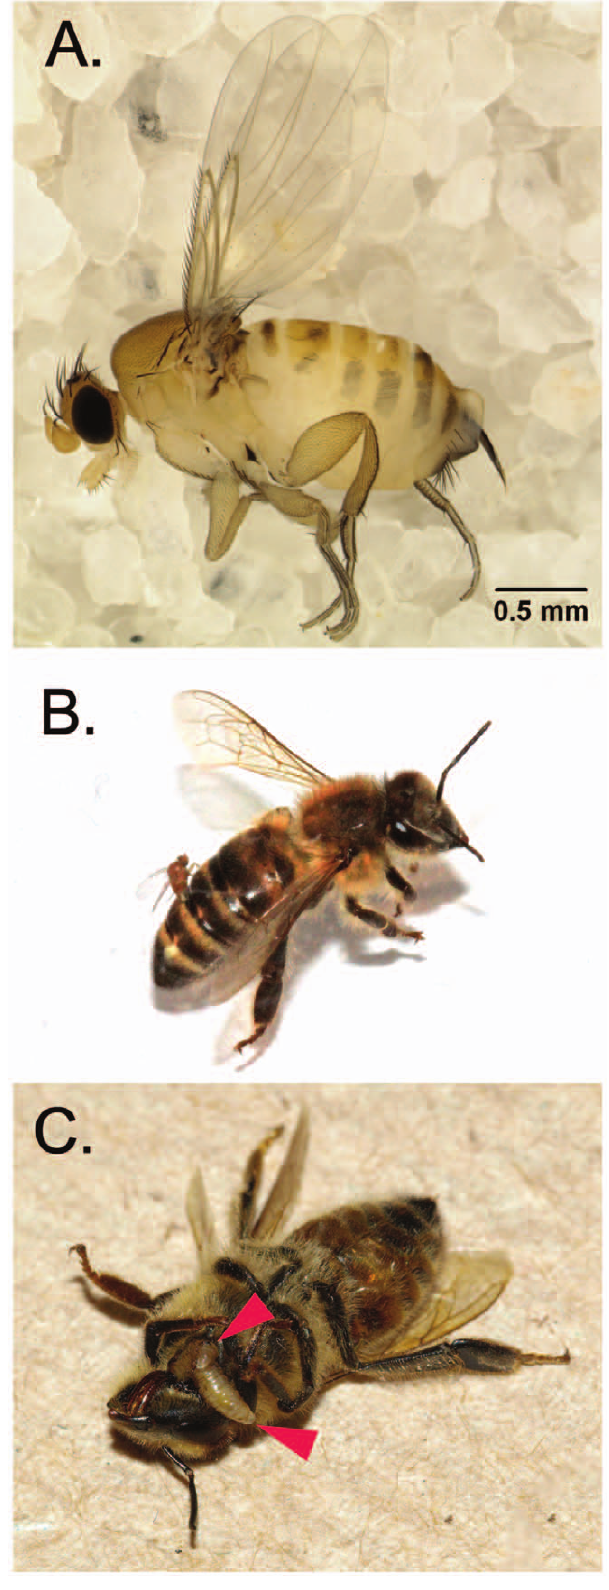
Figure 2. Images of Apocephalusborealis and honey bees. (A) Adult female A. borealis . (B) Female A. borealis ovipositing into the abdomen of a worker honey bee. (C) Two final instar larvae of A. borealis exiting a honey bee worker at the junction of the head and thorax (red arrows).